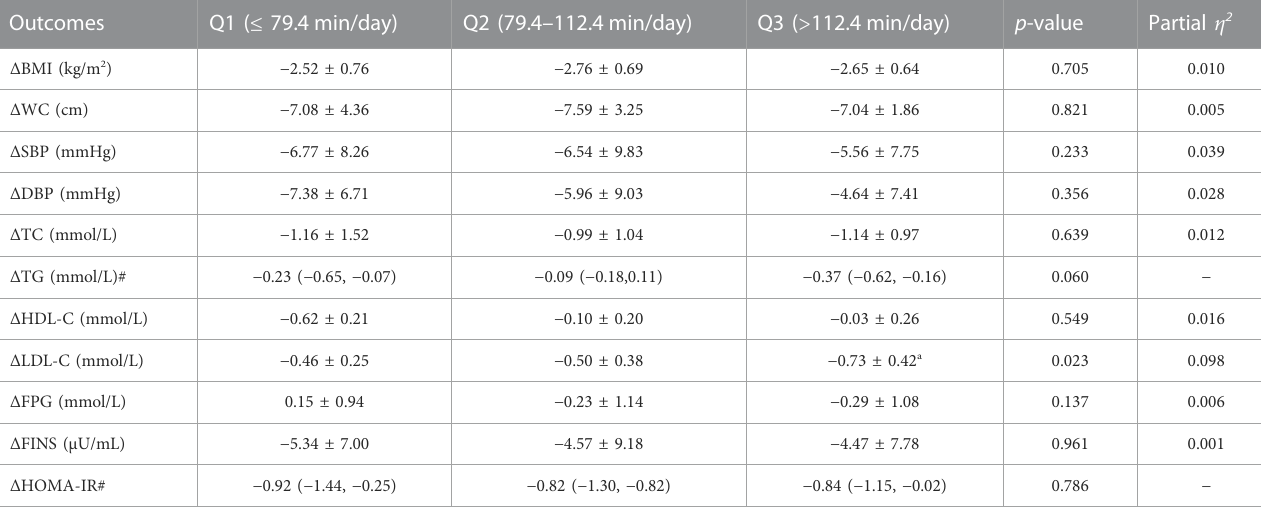
BMI,bodymassindex;DBP,diastolicbloodpressure;FPG,fastingplasmaglucose;FINS,fastinginsulin;HOMA-IR,homeostasismodelassessmentindexofinsulinresistance;HDL-C,high-density lipoprotein cholesterol; LDL-C, low-density lipoprotein cholesterol; SBP, systolic blood pressure; TC, total cholesterol; TG, Triglycerides. a Indicates p < 0.05 compared with Q1 groups; #, indicates that the data is non-normally distributed, differences were compared using Kruskal-Wallis test. One-way analysis of covariance analysis corrected the baseline values of the indicators.